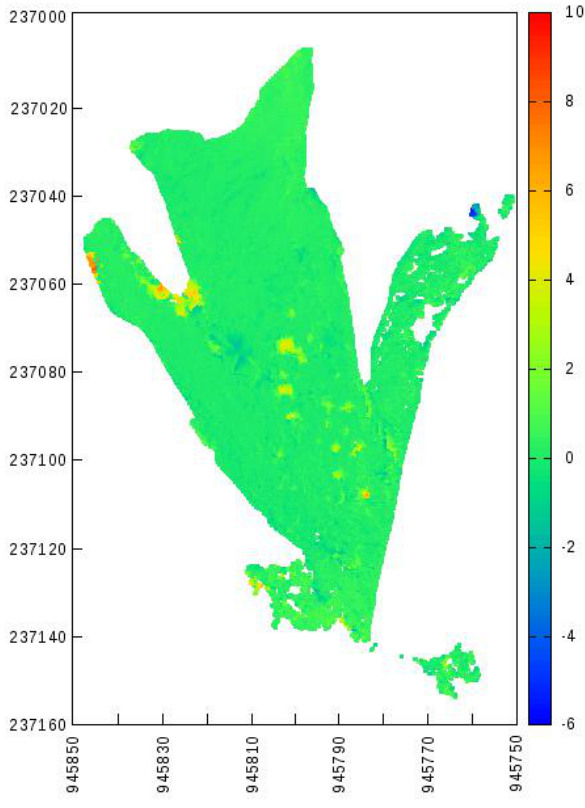
Figure 6. Altitude difference [m] at the toe (MVS